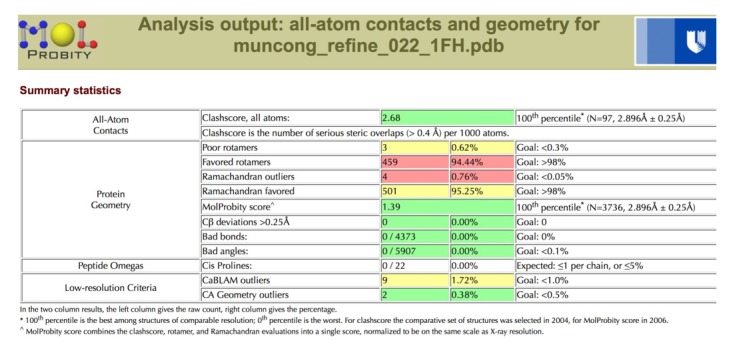
DOI:
http://dx.doi.org/10.7554/eLife.22567.031